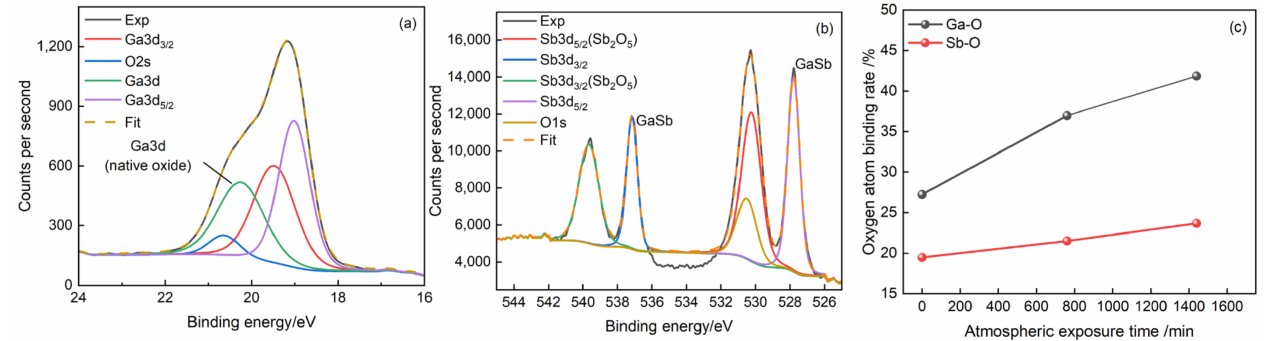
Figure 3. XPS analysis of surface oxides on GaSb substrates. ( a ) Native gallium oxide on fresh samples; ( b ) Native antimony oxide on fresh samples; ( c ) the change in the atomic ratio (atoms bonding to oxygen) with exposure to the